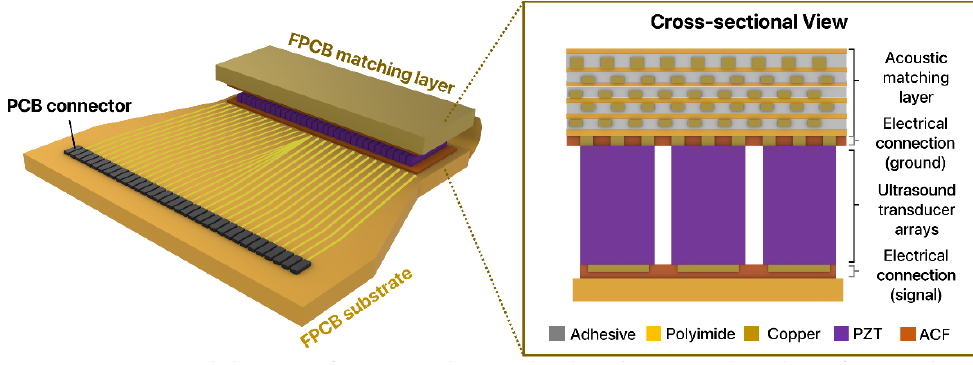
Figure 1. Conceptual diagram of a FPCB substrate developed as a matching layer for a 1D linear ultrasound transducer array.